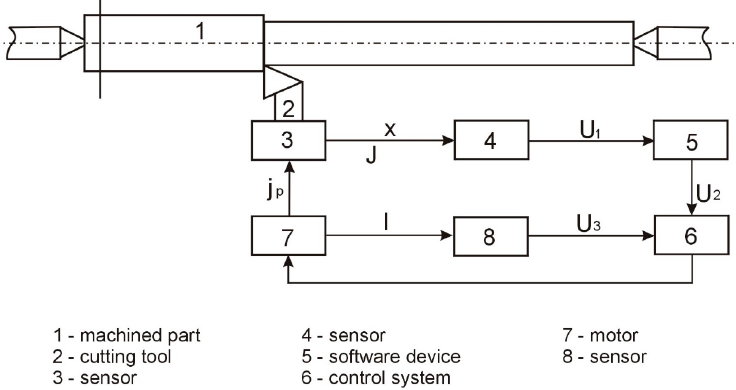
Figure 9. Functional diagram of the adaptive device.